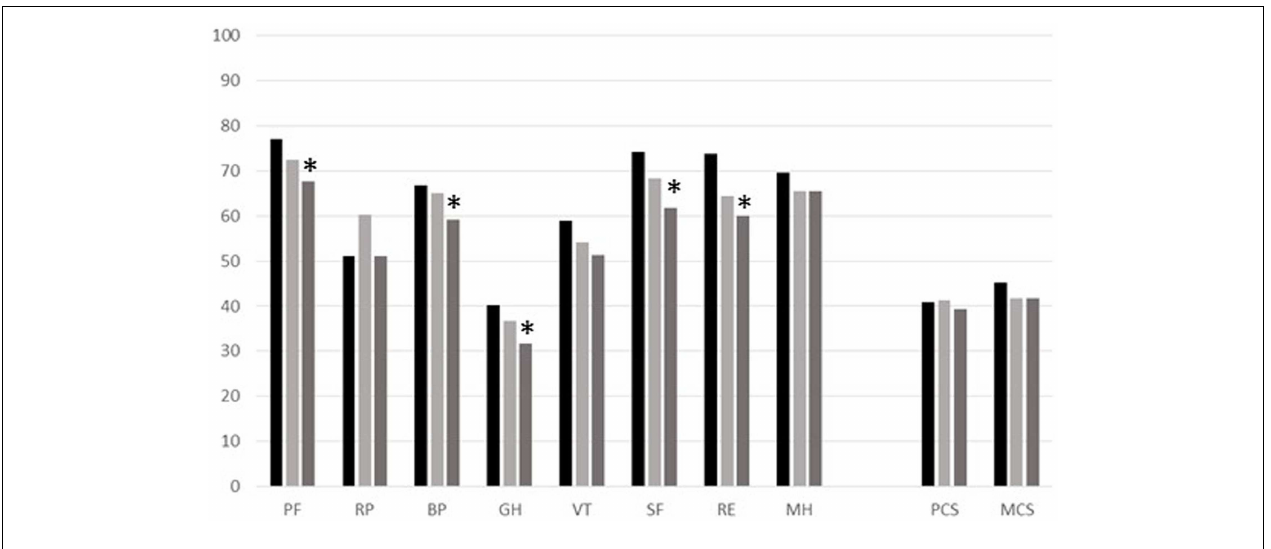
Health (GH),Vitality (VT), Social Functioning (SF), Role-Emotional (RE), Mental Health (MH), Physical component summary (PCS), and Mental component summary (MCS). *Significant p- values between T0 andT2.